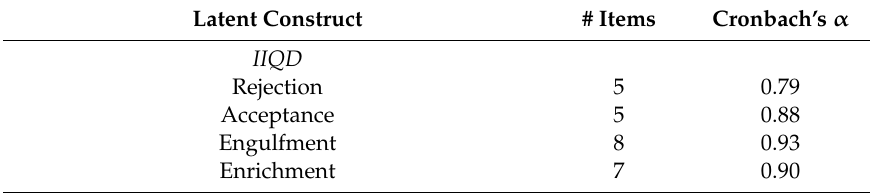
Table 3. Reliability and Number of Items of Latent Scales Indicated by Internal